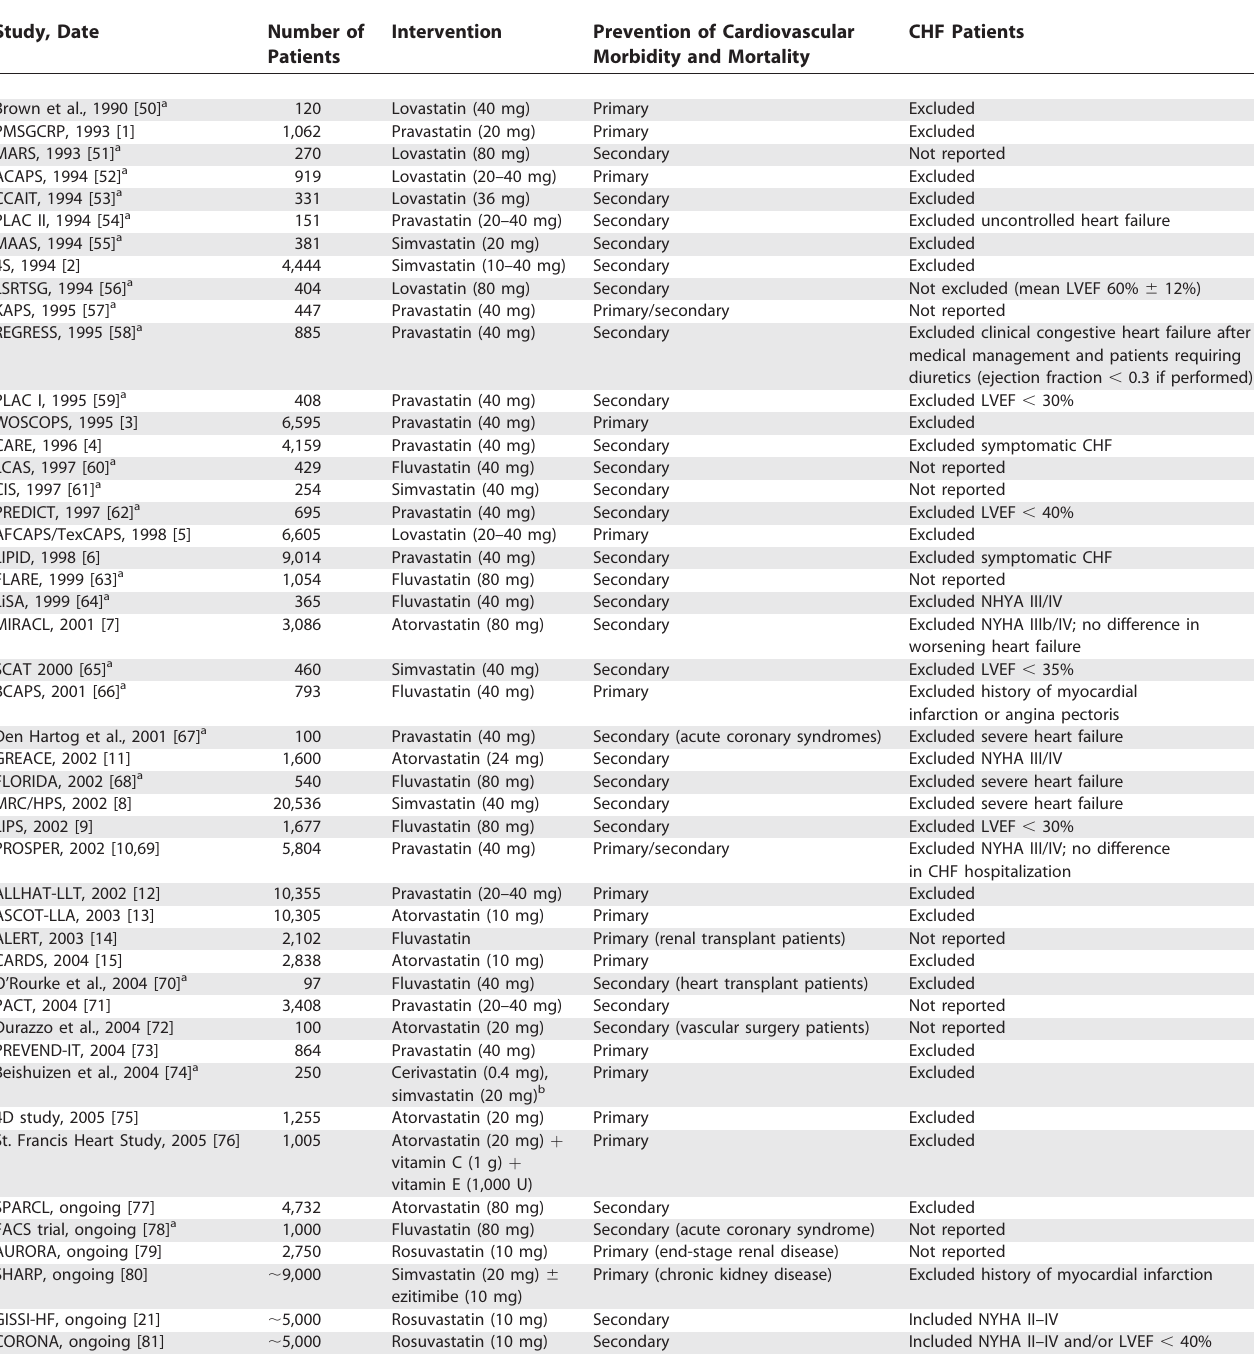
Table 1. Placebo-Controlled Statin Trials and CHF